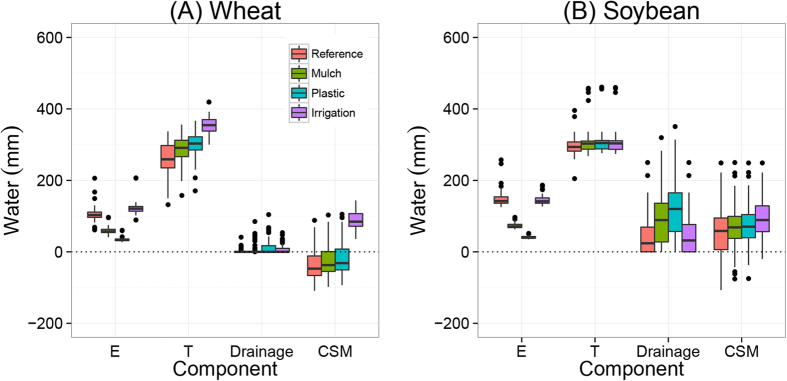
Simulated components of the water balances for wheat (A) and soybean (B) as function of straw mulching, plastic film cover and irrigation.